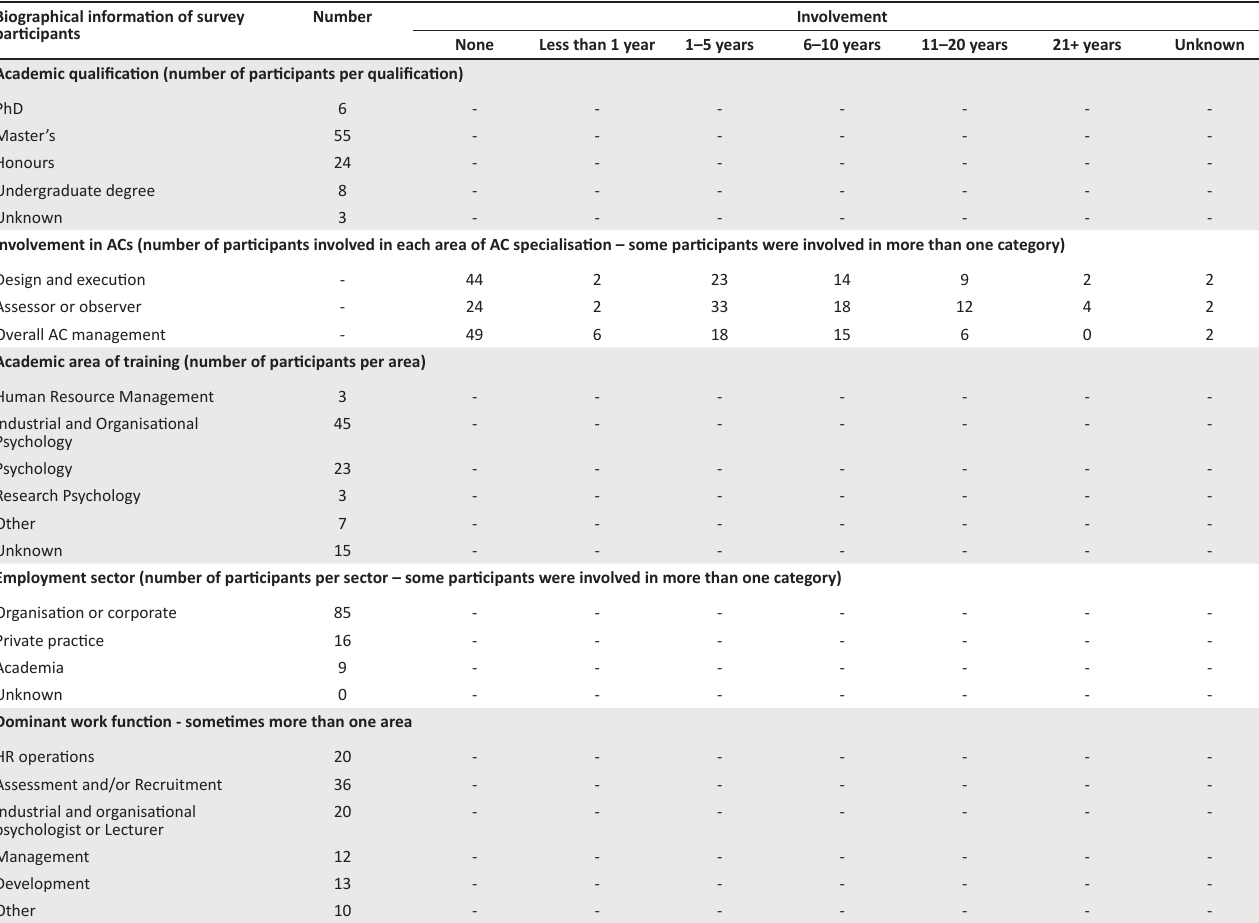
TABLE 1-A1: Biographical information of survey participants ( n = 96) Biographical information of survey